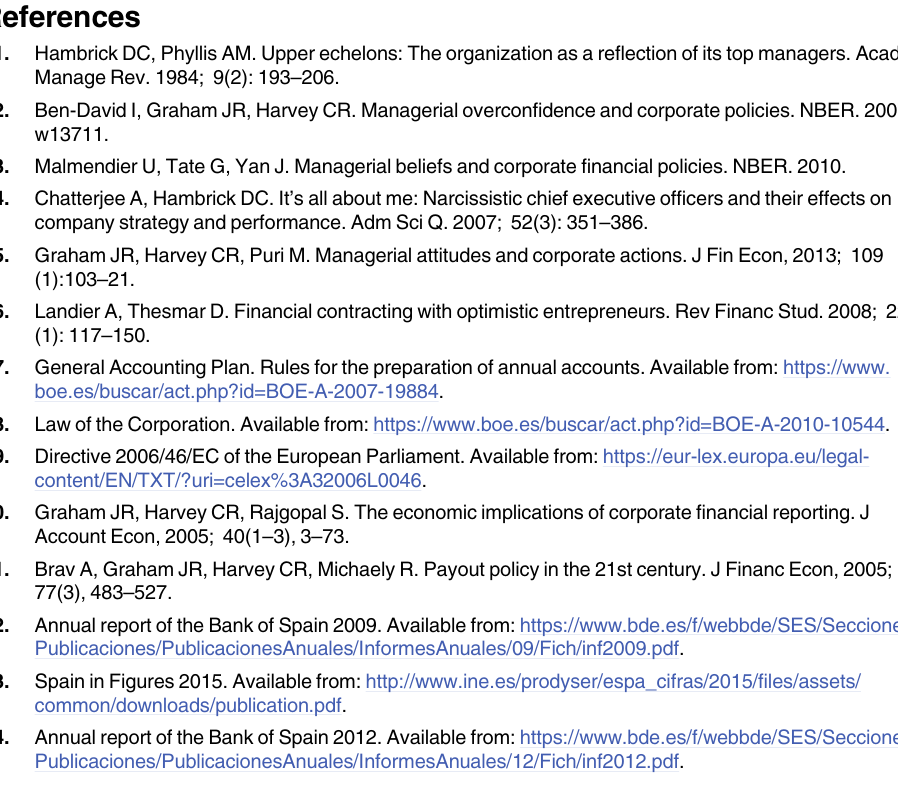
S2 Table. Real values and theoretical values of each stratum. S3 Table. CEO profile. S4 Table. Results from the psychometric tests. S5 Table. Correlations between CEOs’